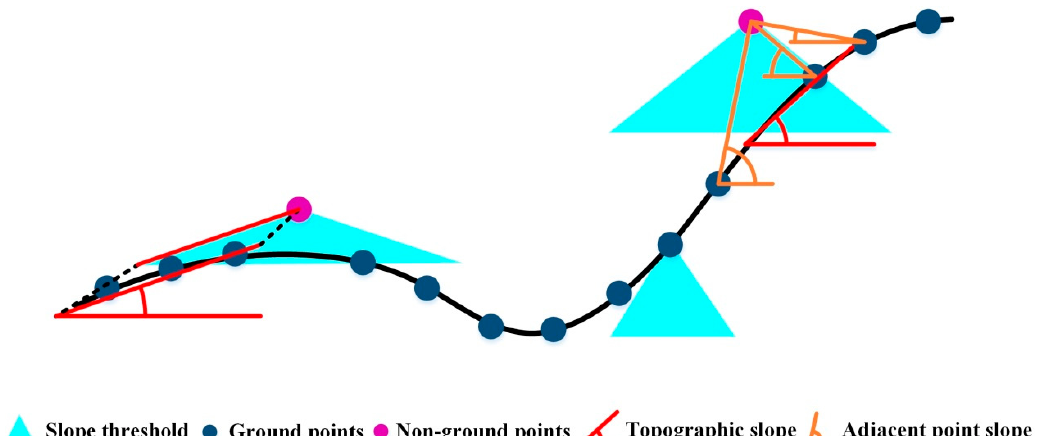
Figure 1. Schematic diagram of adaptive slope-based filters.